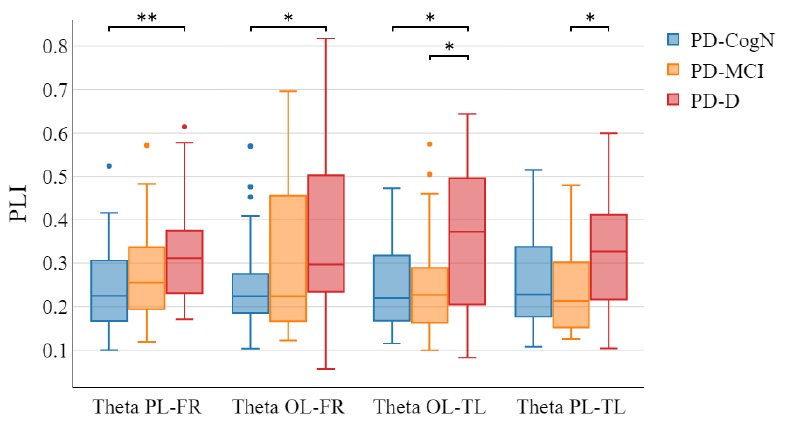
Figure 10. Distributions of theta PLI between selected regions which are significantly different between patient’s groups (* p < 0.05, ** p <